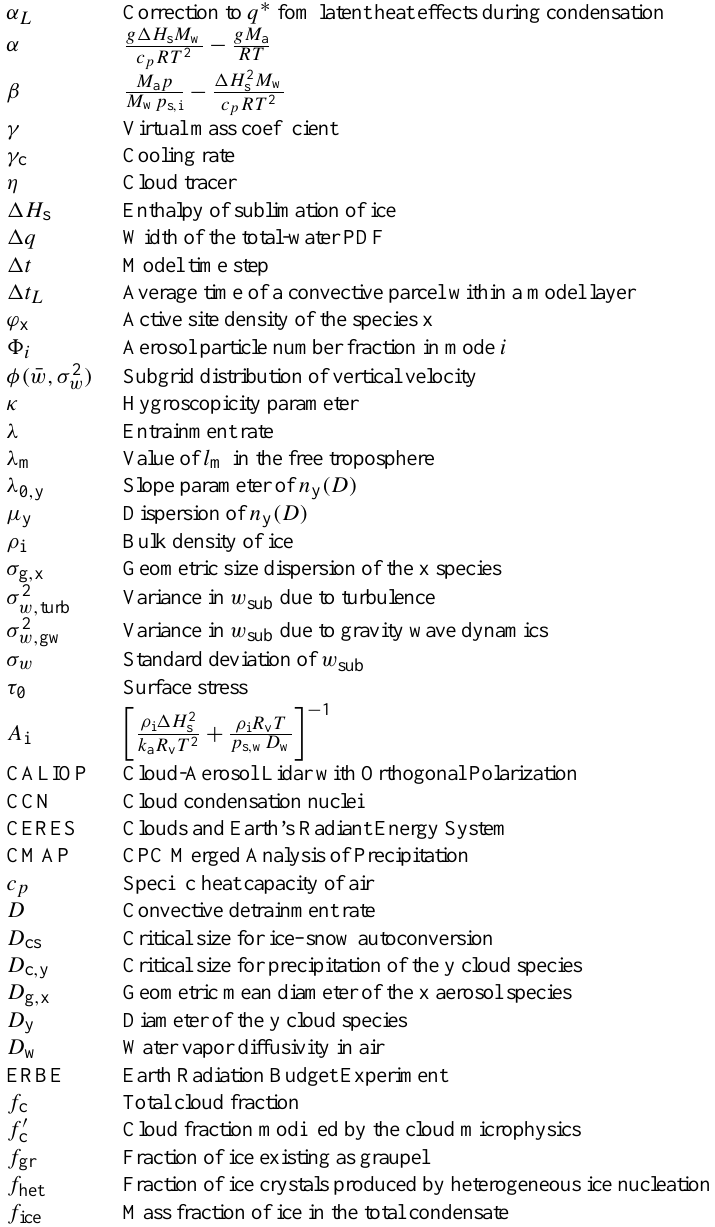
Table D1. List of symbols and